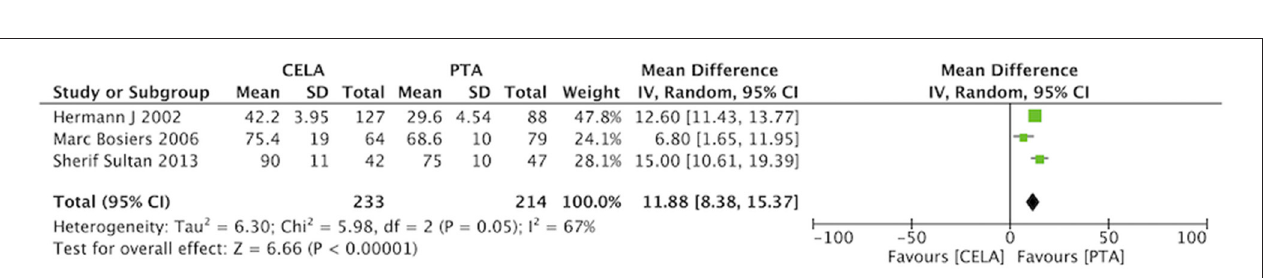
FIGURE 3 | Forest plot for 6-month patency. Random, a randomized effects model; CI, confidence intervals. The green squares stand for the weight of studies in meta-analysis. Black rhomboid represents the effects of combination of above three studies.